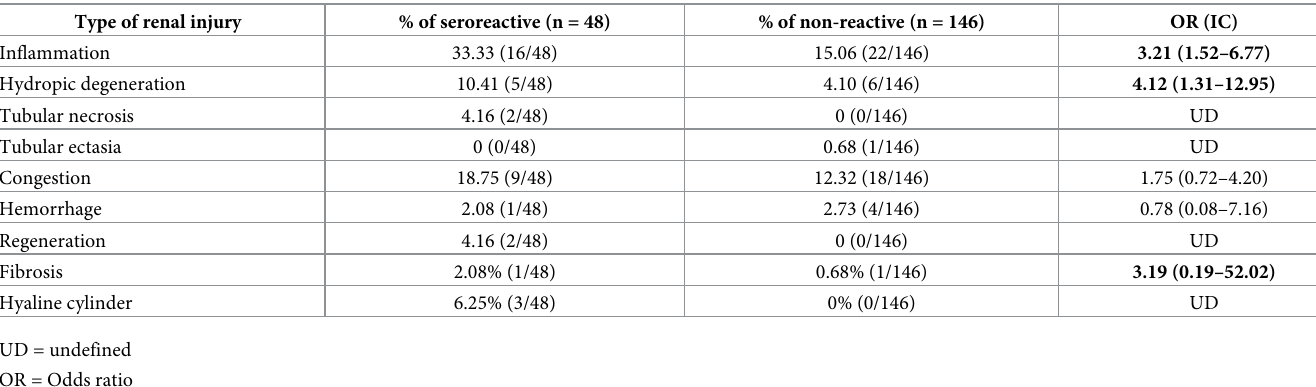
Table 2. Frequency of histopathological changes and association between seroreactivity in MAT and presence of changes in seroreactive animals for Leptospira sp. Type of renal injury % of seroreactive (n = 48)